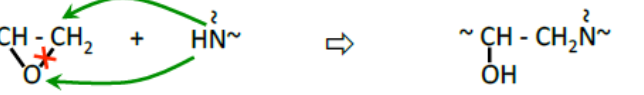
Figure 4. Schematic depiction of the crosslinking reaction between an epoxy group and an amine group, involving N–C and O–H bond formation between, and C–O and N-H bond breakage. The epoxy oxygen transforms into an alcohol group and the epoxy carbon transforms into a linear alkane carbon.